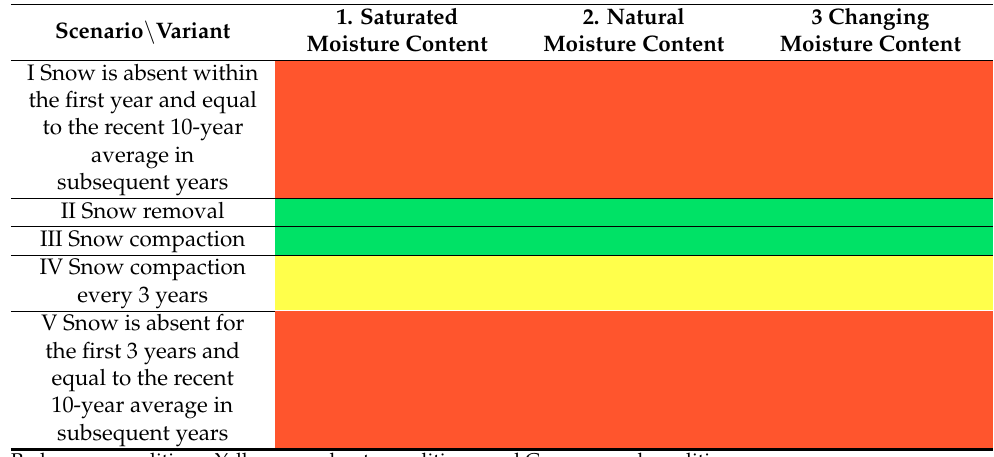
Table 8. Optimal conditions for protective layer